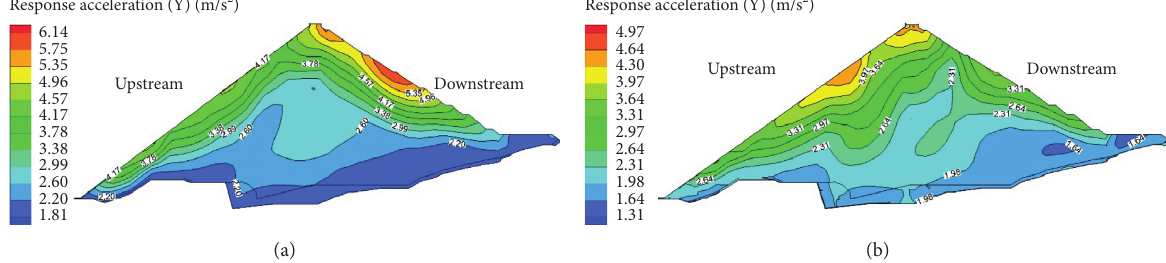
Figure 6: Distribution of response acceleration in the vertical direction (m/s 2 ). (a) The distribution of response acceleration based on UHS. (b) The distribution of response acceleration based on site-related response spectrum using scenario earthquake (SRRS).